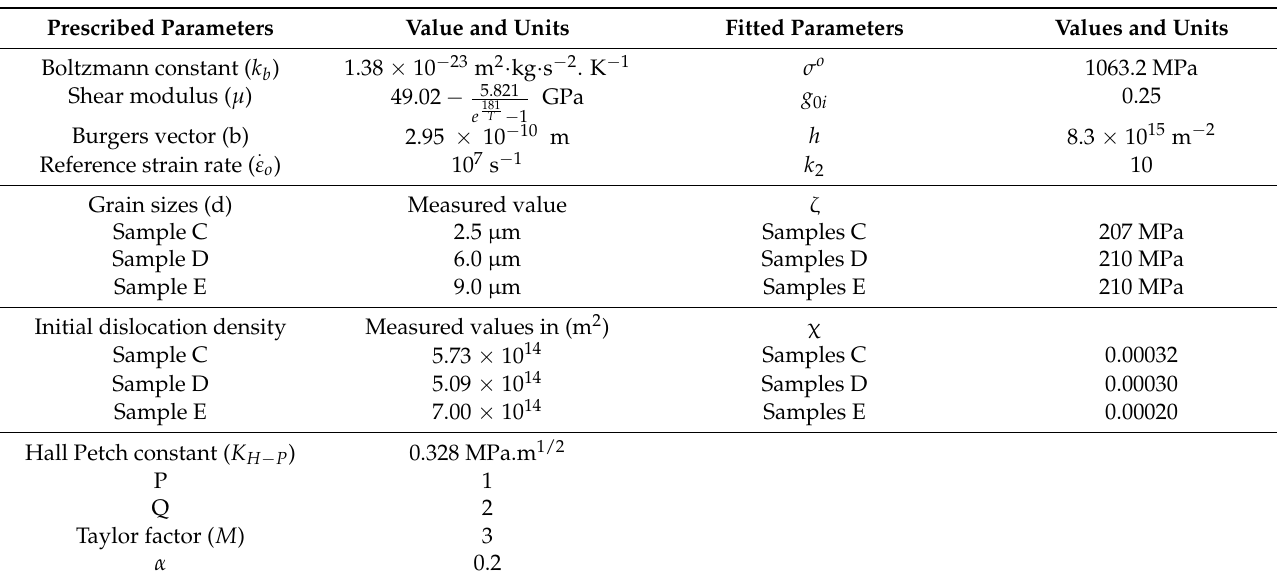
Table 5. A summary of constitutive flow stress model parameters for DMLS